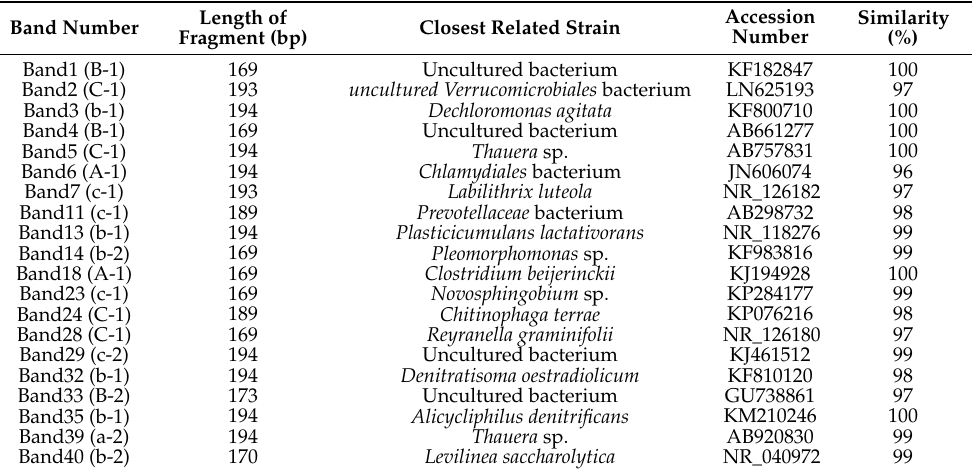
Table 1. BLAST results of selected DGGE bands from the DGGE